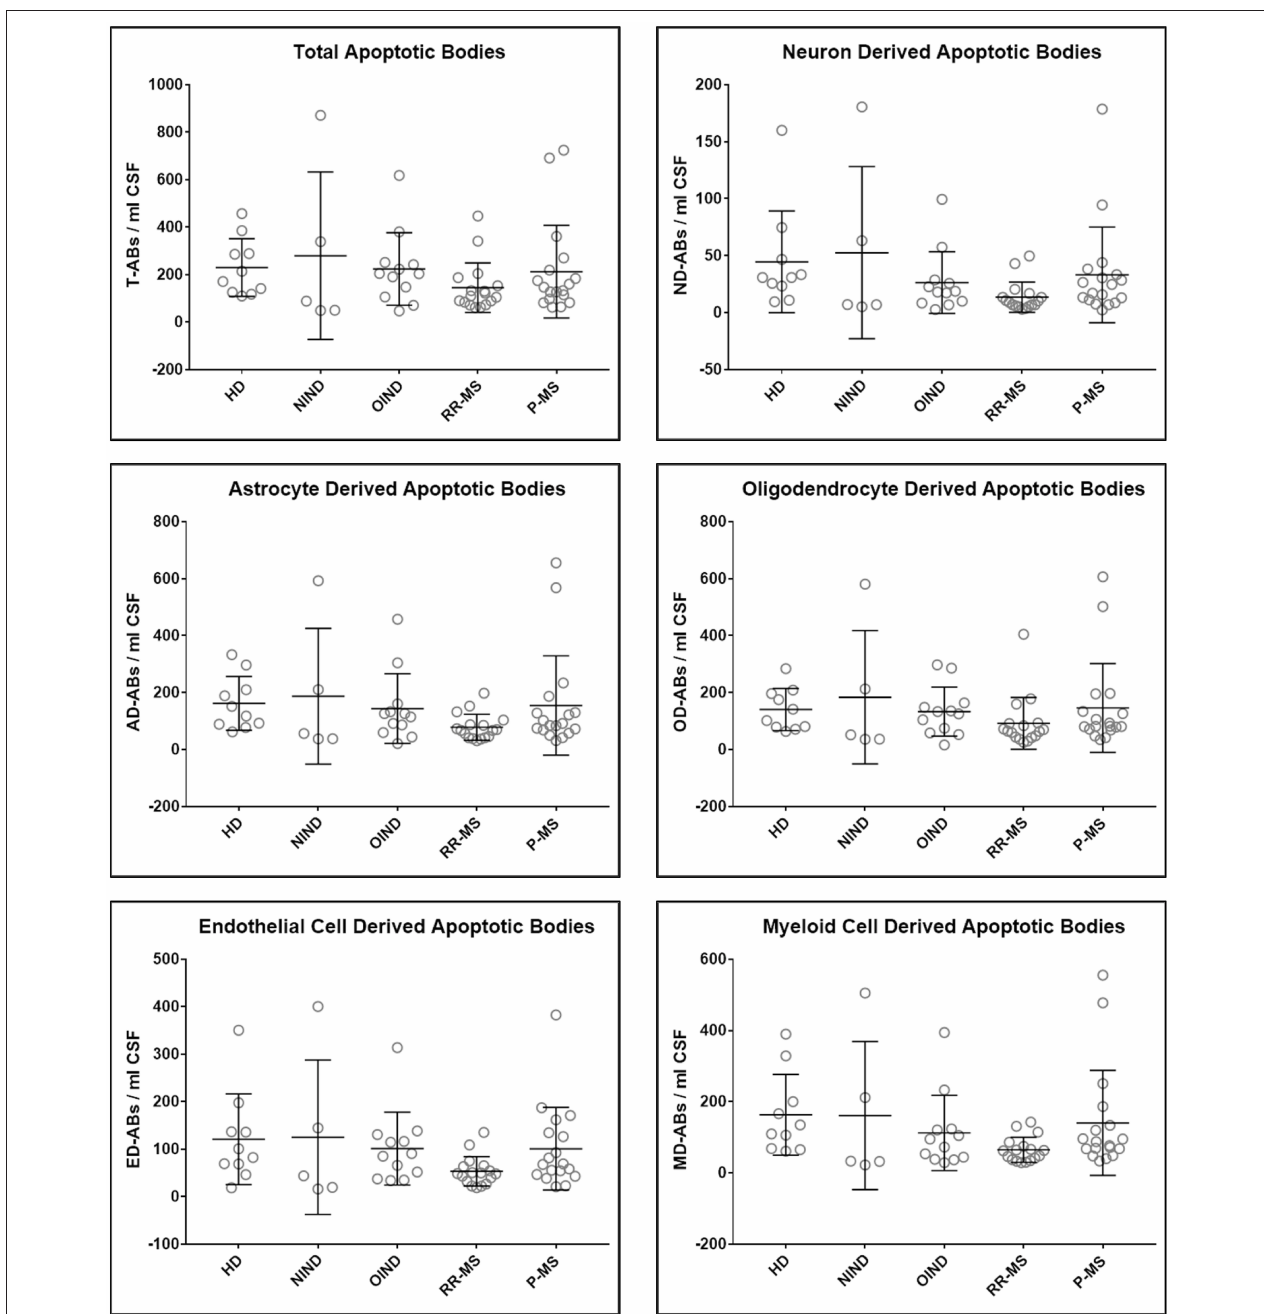
FIGURE 4 | Plots of total and CNS cell-specific ABs adjusted for CSF volume (ABs/ml CSF). Each point represents individual subject; and error bars represent standard deviation ( n : HD = 10, NIND = 5, OIND = 12, RR-MS = 17, and P-MS = 18); data were analyzed using one-way ANOVA.